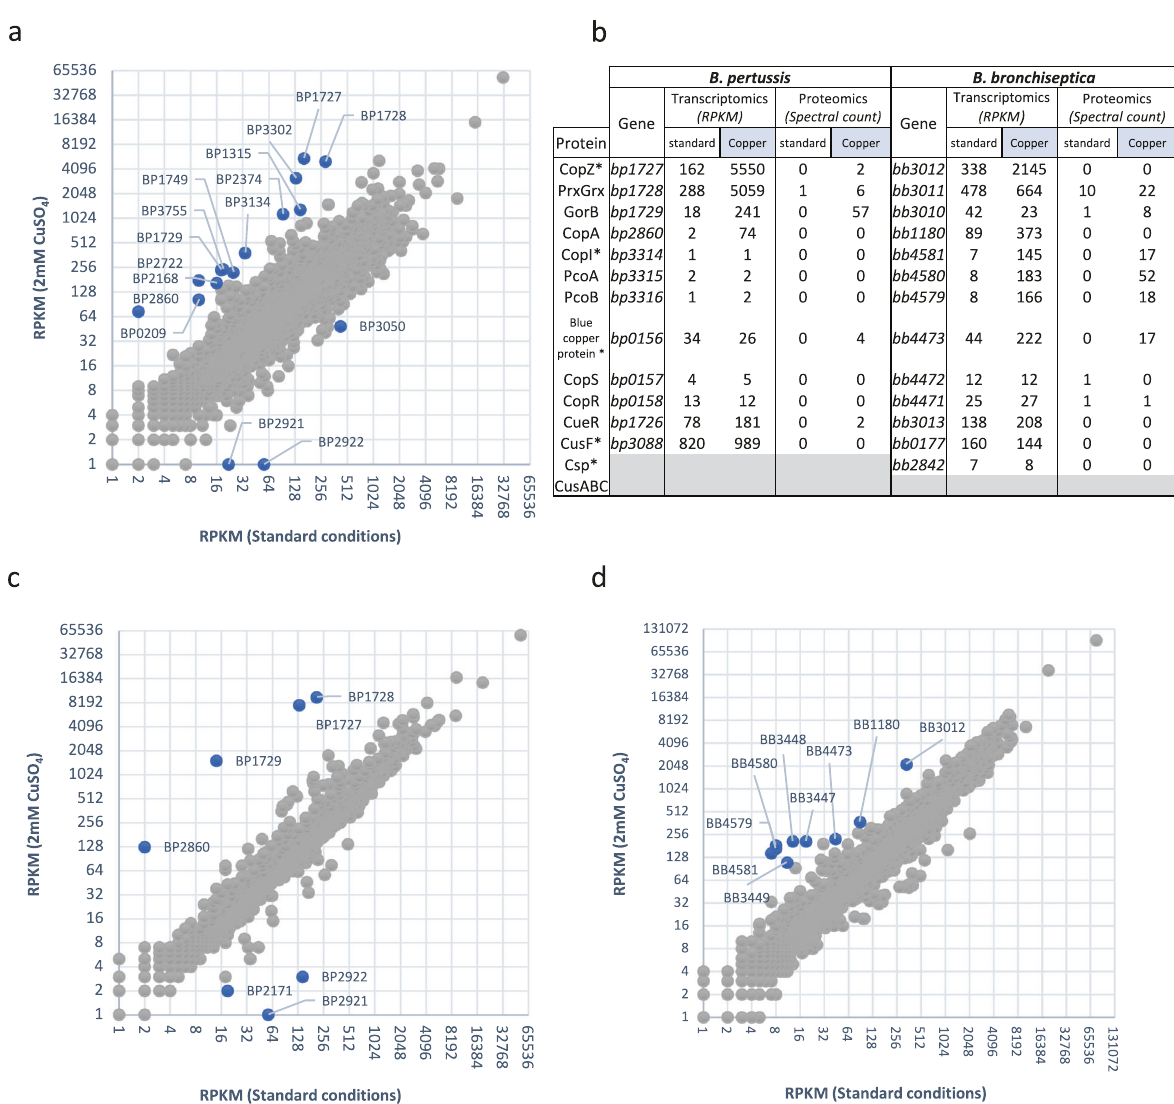
Fig. 2 Copper regulation of homeostasis systems in B. pertussis and B. bronchiseptica . ( a , c , and d ) RNAseq analyses of B. pertussis grown for 16 h in the presence of 2 mM CuSO 4 in SS medium ( a ), B. pertussis grown in SS medium and treated for 30 min with 2 mM of CuSO 4 ( c ), and B. bronchiseptica grown for 12 h in the presence of 2 mM CuSO 4 ( d ). Comparisons were made with bacteria grown in standard conditions. Each gene is represented by a dot. The x and y axes show absolute levels of gene expression in reads per kilobase per million base pairs (RPKM) in standard and copper conditions, respectively. The genes indicated in blue indicate genes of interest with the strongest regulation factors. The full sets of data are shown in Supplementary Tables S1, S2 and S3. ( b ) Summary of the transcriptomic and proteomic analyses performed after growing bacteria as in (a) and (c) in medium supplemented with 2 mM CuSO 4 . Standard culture conditions were used for comparisons. * indicates small proteins dif fi cult to detect by global proteomic approaches. COMMUNICATIONS BIOLOGY| (2021) 4:46